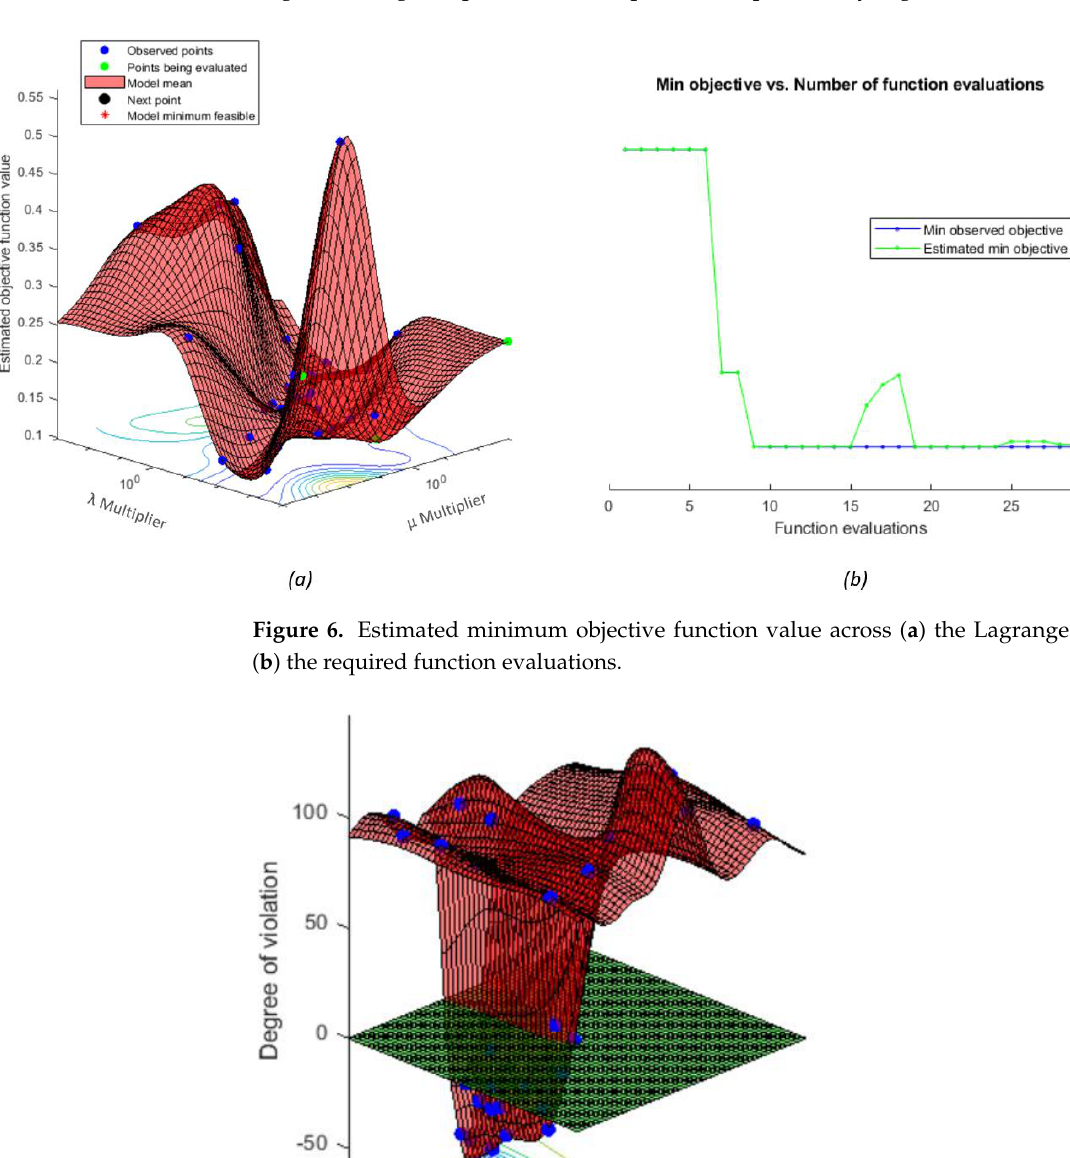
Figure 5. Power deficits applying the genetic algorithm mechanism.